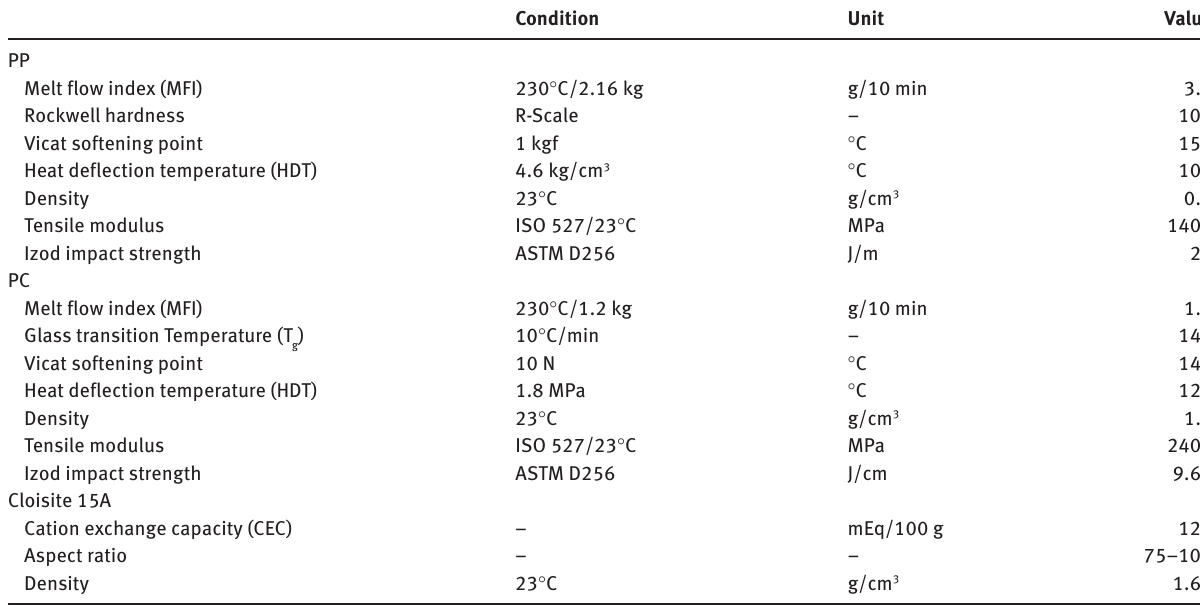
Table 1: The properties of polymer matrix components and NC.